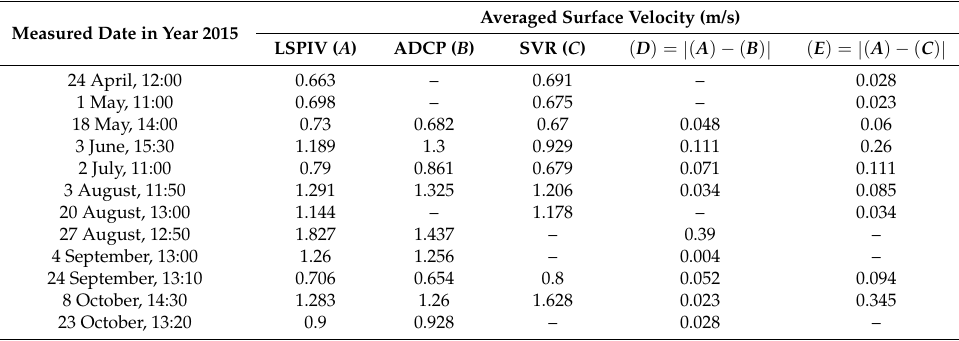
Table 2. Averaged surface velocities from ADIS, ADCP, and SVR